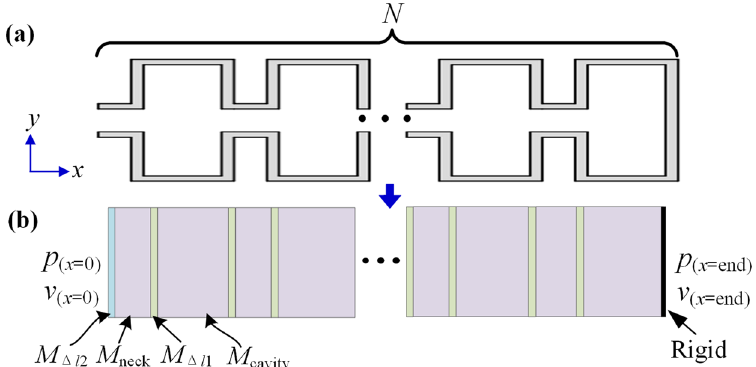
Figure 7. ( a) 2D cross section of the MHR and (b) its effective